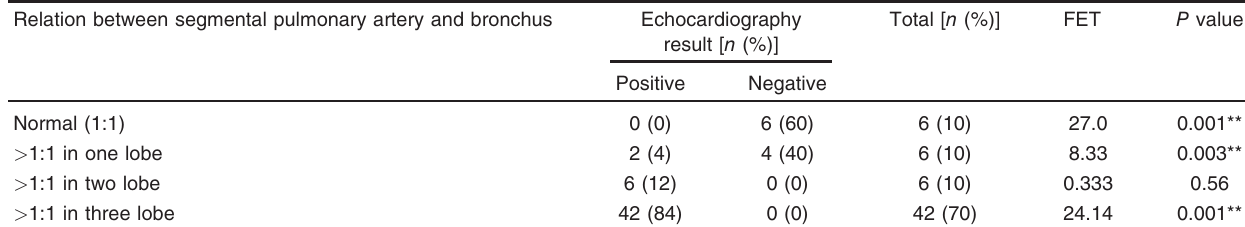
Table 9 Correlation between echocardiography results of pulmonary hypertension and the relation between segmental pulmonary arteries and related bronchi Relation between segmental pulmonary artery and bronchus